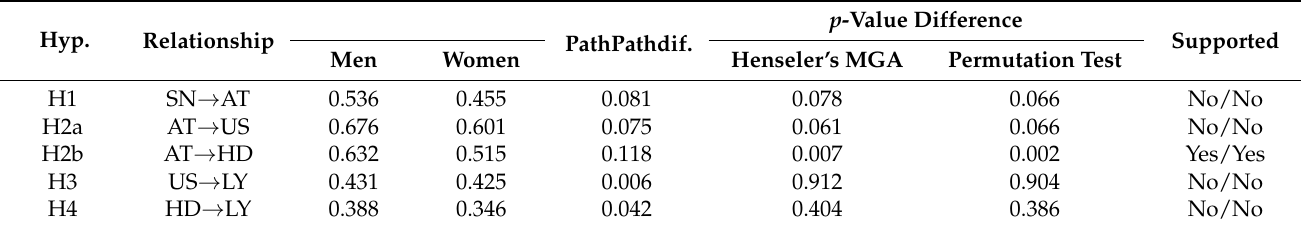
Table 9. Multigroup Analysis.